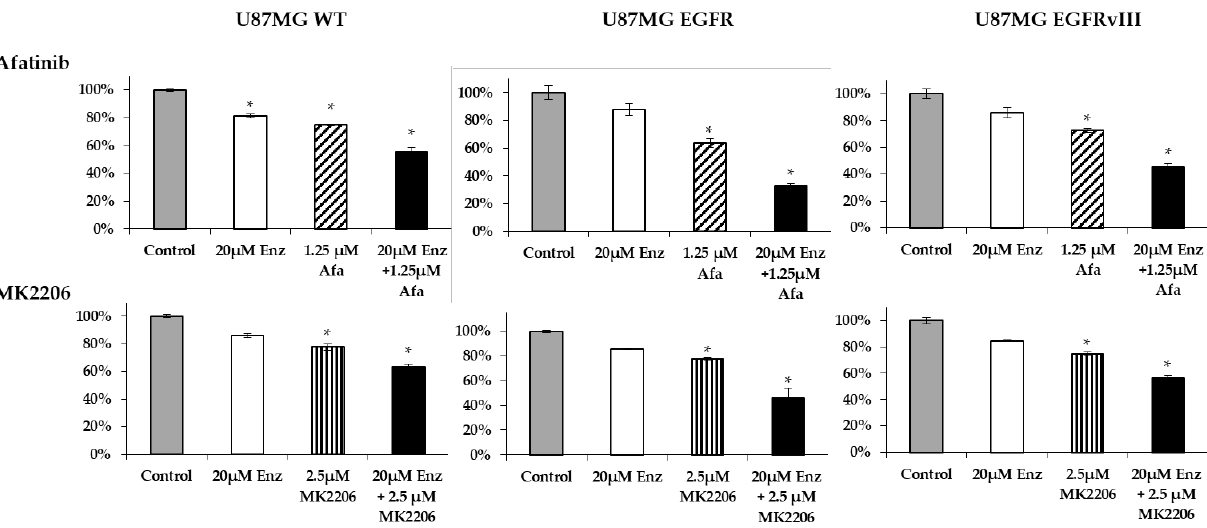
Figure 8. The combination effect of an AR antagonist with EGFR/AKT inhibitor in U87MG subclones. U87MG WT, U87MG EGFR, and U87MG EGFRvIII cells were treated for 72 h with 1.25 µ M afatinib (Afa) (striped columns) or 20 µ M enzalutamide (Enz; white columns) alone or in combination (black columns); 2.5 µ M MK2206 (striped columns) or 20 µ M enzalutamide (Enz; white columns) alone or in combination (black columns). Cell density is expressed as the percentage of cells treated with vehicle (gray columns). The results are the mean ± SD. * p < 0.05 indicates significant results of each treatment compared to vehicle-treated cells (Student’s two-tailed t -test).